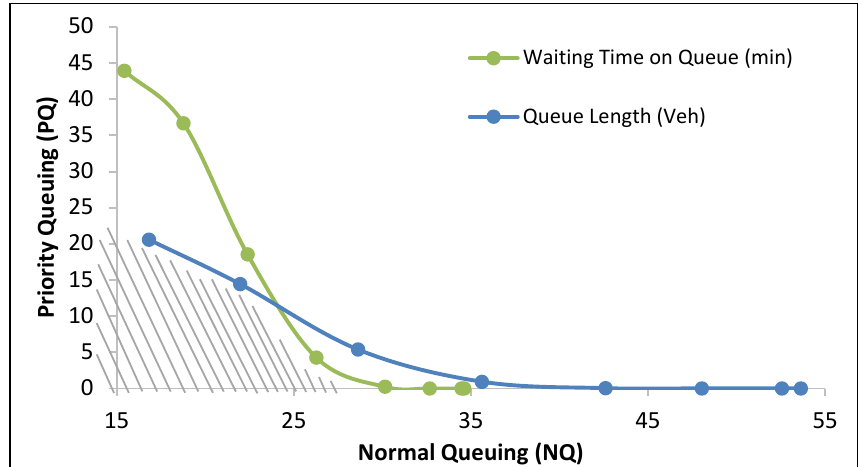
Fig. 8. Optimisation of Queuing System at the TOTAL Petrol Filling Station in Makurdi